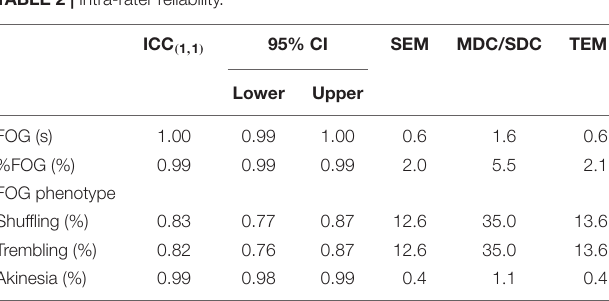
TABLE 2 | Intra-rater reliability. TABLE 3 | Inter-rater